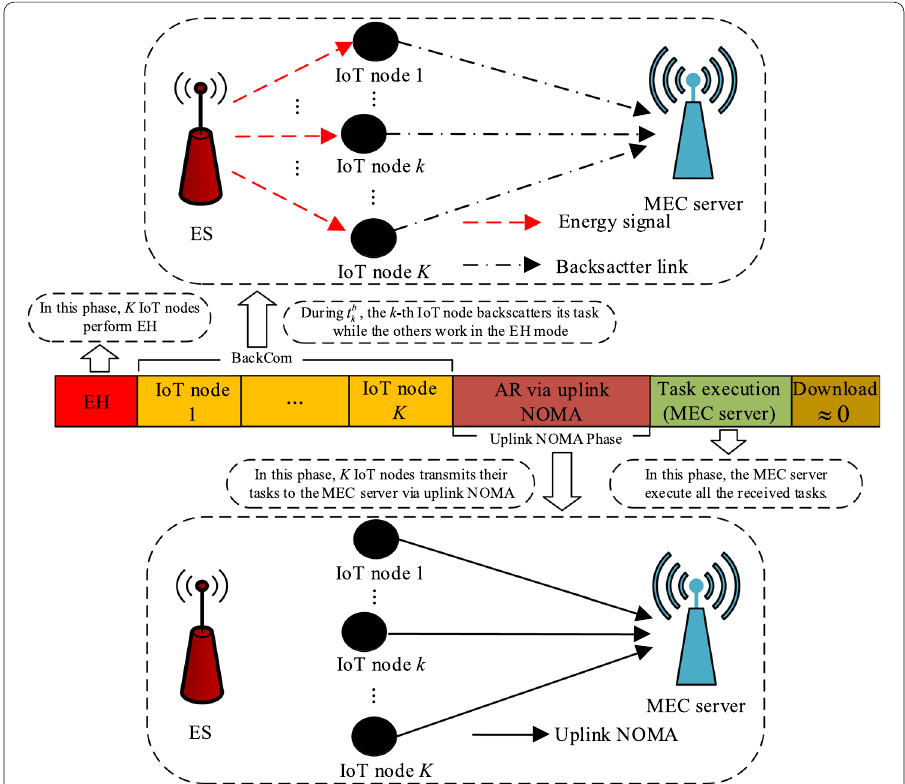
Fig. 1 The frame structure of the considered